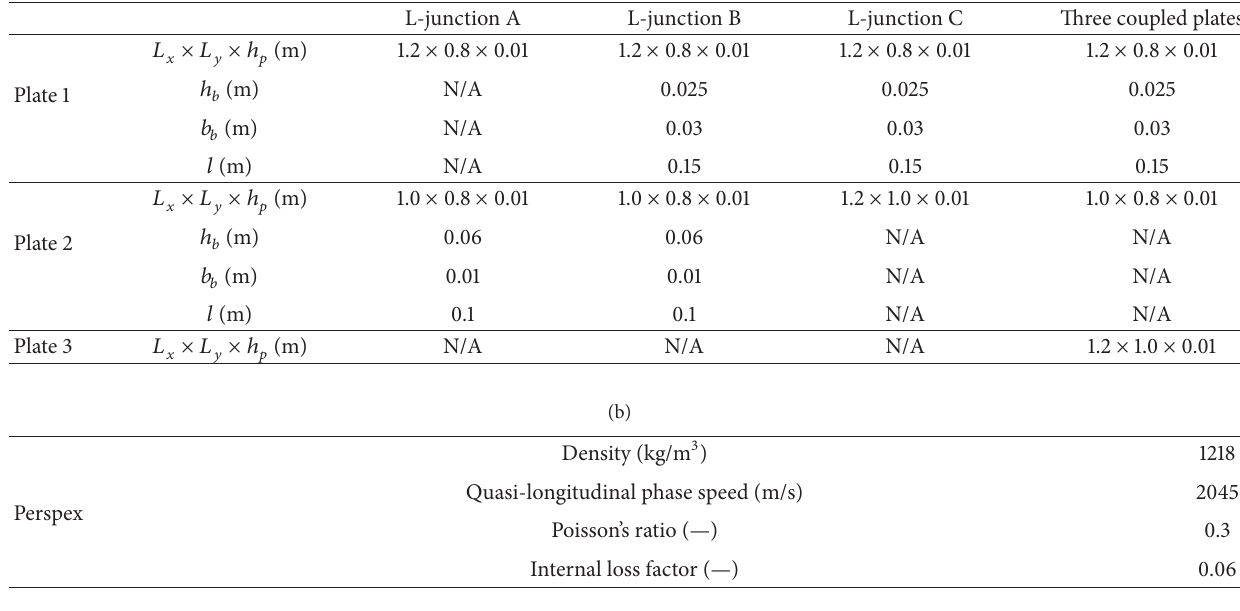
Table 1: Material properties and plate dimensions.